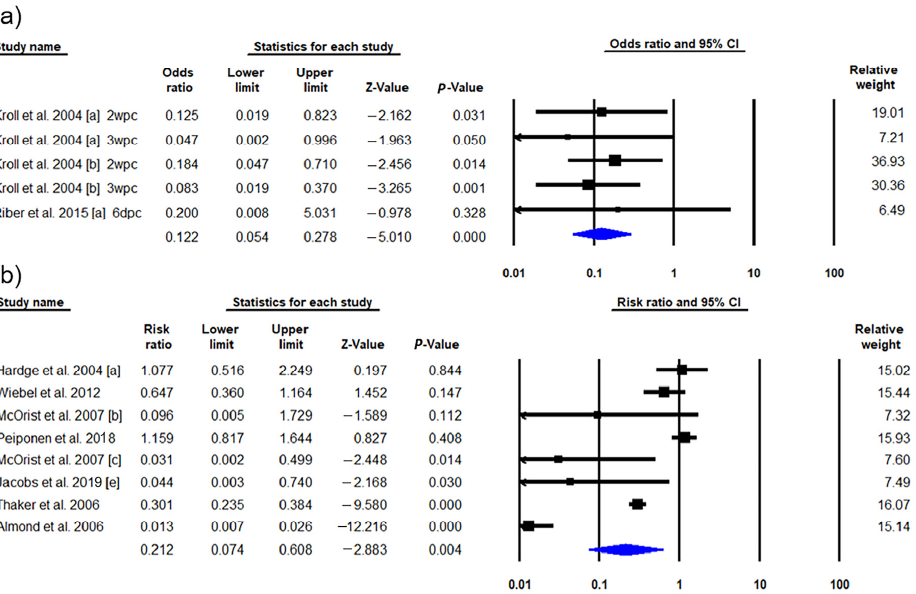
Figure 3. Meta-analysis forest plots comparing the effects of commercial vaccines against L. intracellularis using the pooled OR ( a ) or the pooled RR ( b ) with 95% CI. ( a ) Compar- ison of the reductions of fecal shedding between the vaccinated and control groups. ( b ) Mor- tality rate. [a], [b], [c] and [e] indicated each trials containing interested outcomes in the se- lected studies (Kroll et al., 2004 [a][b] [44], Riber et al., 2015 [a] [51], Hardge et al., 2004 [a] [49], Weibel et al., 2012 [7], Weibel et al., 2012 [7], McOrist et al., 2007 [b][c] [48], Peiponen et al., 2018 [40], Jacobs et al., 2019 [e] [50], Thaker et al., 2006 [42], Almond et al., 2006